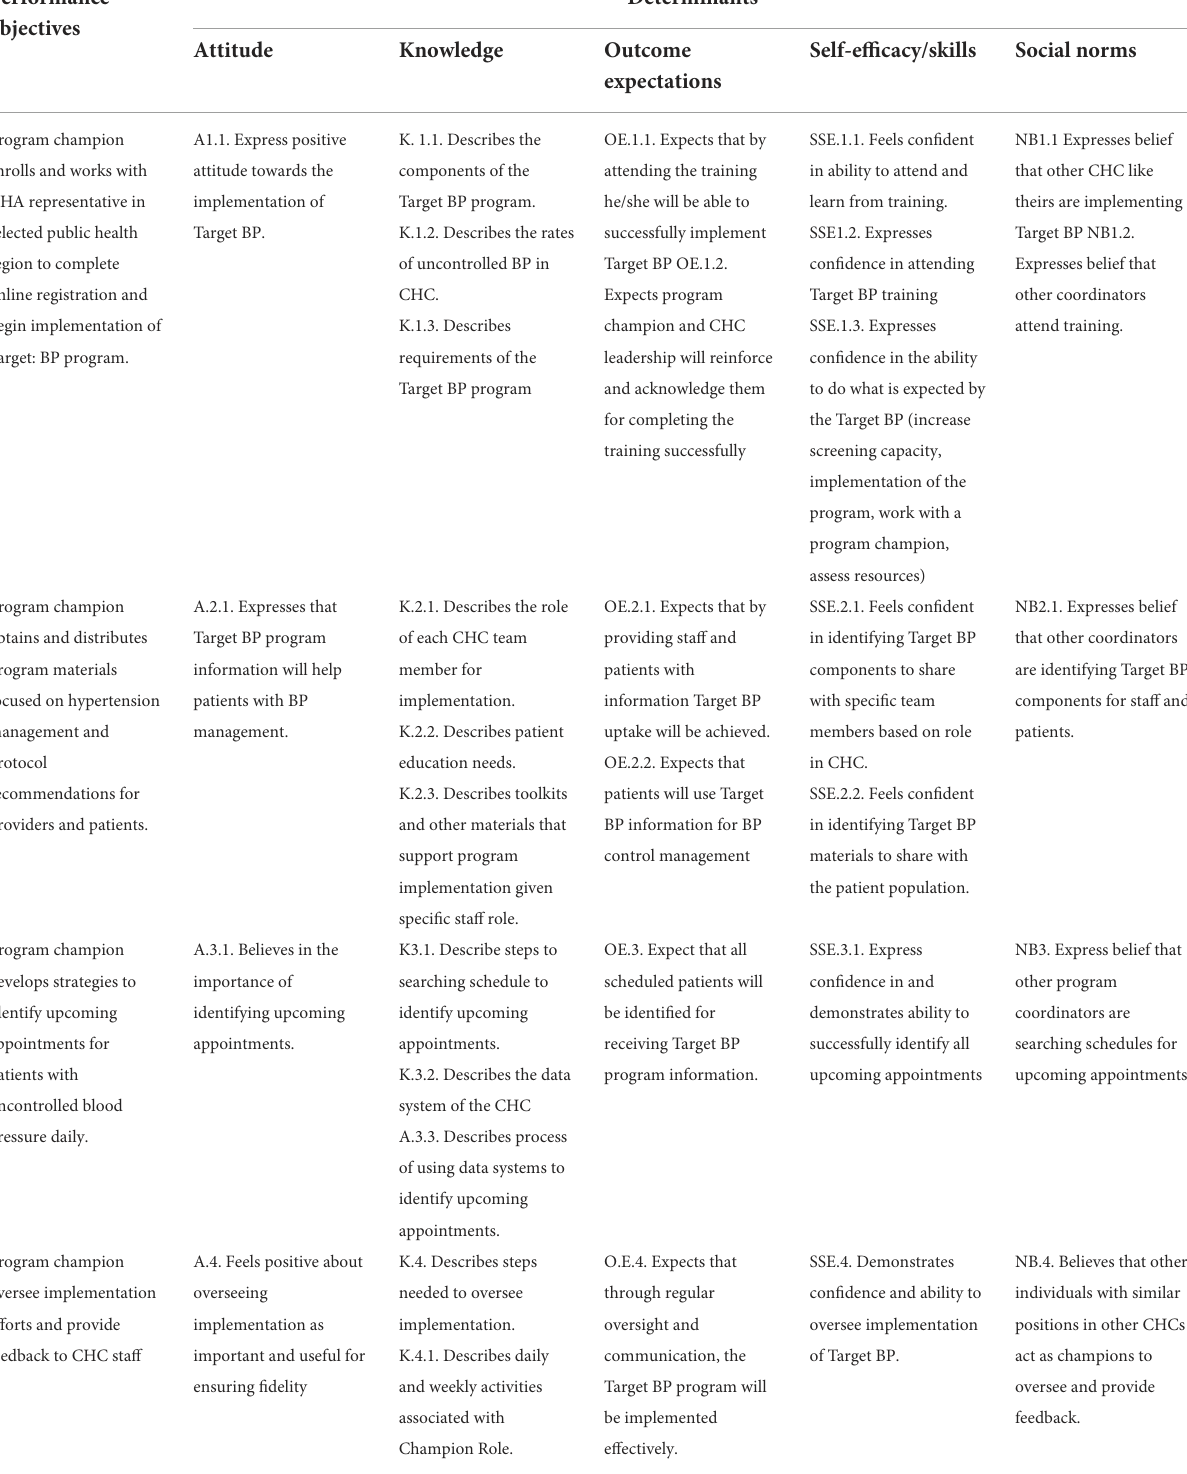
TABLE 4 Example of partial matrices of change objectives for selected examples. Program: Target:BP Behavioral outcome: Implement the Target:BP program into hypertension management